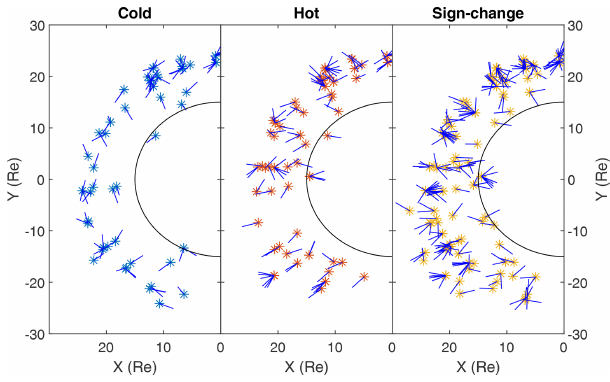
Figure 13. Location of the events in the GSE XY plane with the average magnetic field direction for the three categories. The black circle represents the 15 R E boundary outside of which the LMHs are searched for.